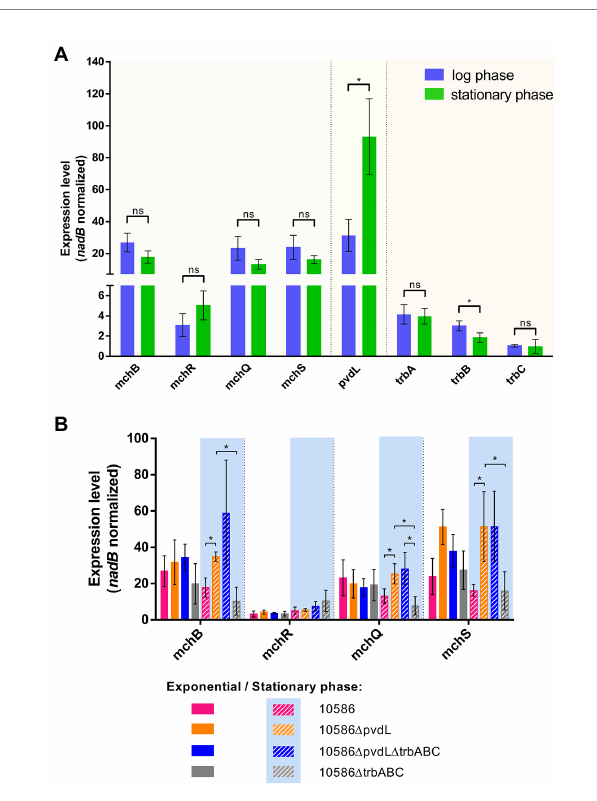
FIGURE 11 Influence of the growth phase on the expression of genes of the mch gene cluster. (A) Comparison of the expression levels of genes involved in pyoverdine, mupirochelin and triabactin pathways in the strain NCIMB 10586 during exponential and stationary growth phases. pvdL biosynthesis gene expression is about three times higher in stationary phase. The expression of mupirochelin and triabactin clusters is not influenced by bacterial growth ( n = 4). Results of Mann–Whitney U-test for between-group pairwise comparison ns p > 0.05, * p < 0.05, ** p < 0.01, *** p < 0.001. (B) Influence of pyoverdine and triabactin production on the mch gene cluster expression. In exponential phase, the levels of expression of all the studied genes appear constant between the different mutants. In stationary phase, mchB, mchQ and mchS levels of transcription are greater when pvdL is deleted ( n = 3). Results of unpaired Student’s t -test with Welsh’s correction * p < 0.05, ** p < 0.01, *** p <